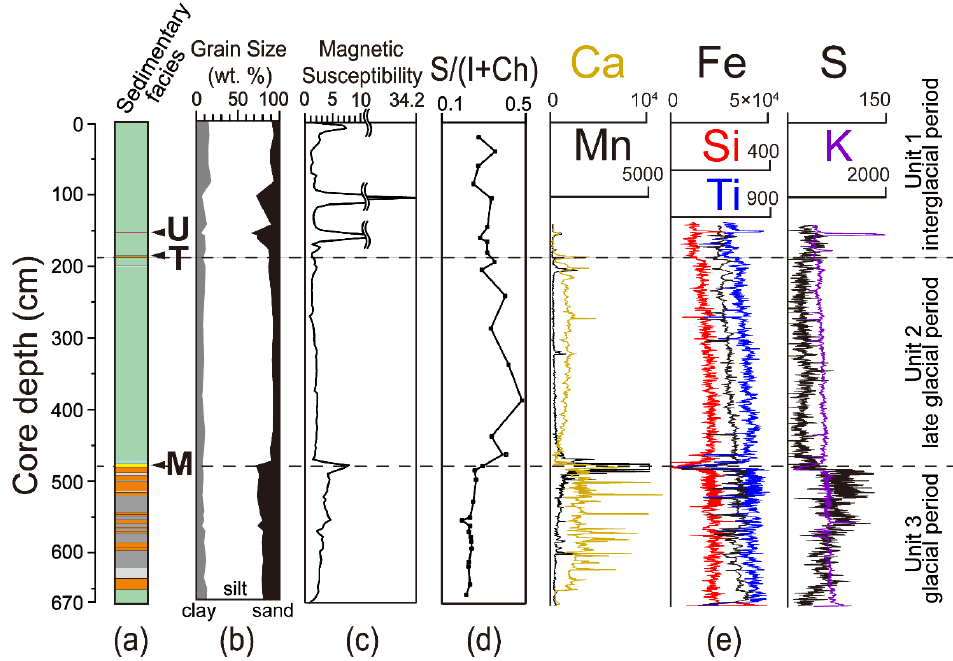
Figure 3. The Core Analysis Data of DPC1801 as Periods. U: U-Oki tephra (9.3 ka), T: TL-1 (11.5 ka), M: Mn-carbonates (14.5 ka). From the left, ( a ) photo image, X-ray radiograph, sedimentary facies; ( b ) grain size distribution; ( c ) magnetic susceptibility; ( d ) the relative proportion of clay minerals-smectite/(illite+chlorite); ( e ) X-ray fluorescence.